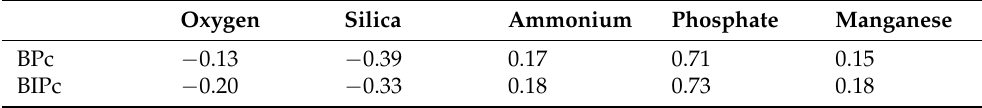
Table 4. Spearman rank correlation coefficients between the estimated total effluxes from sediments obtained from Lipka [41] and trait-based bioturbation and bioirrigation indices, BPc and BIPc ( n = 12). Significant values ( p < 0.05) are highlighted in bold. Oxygen Silica Ammonium Phosphate Manganese BPc − 0.13 − 0.39 0.17 0.71 0.15 BIPc − 0.20 − 0.33 0.18 0.73